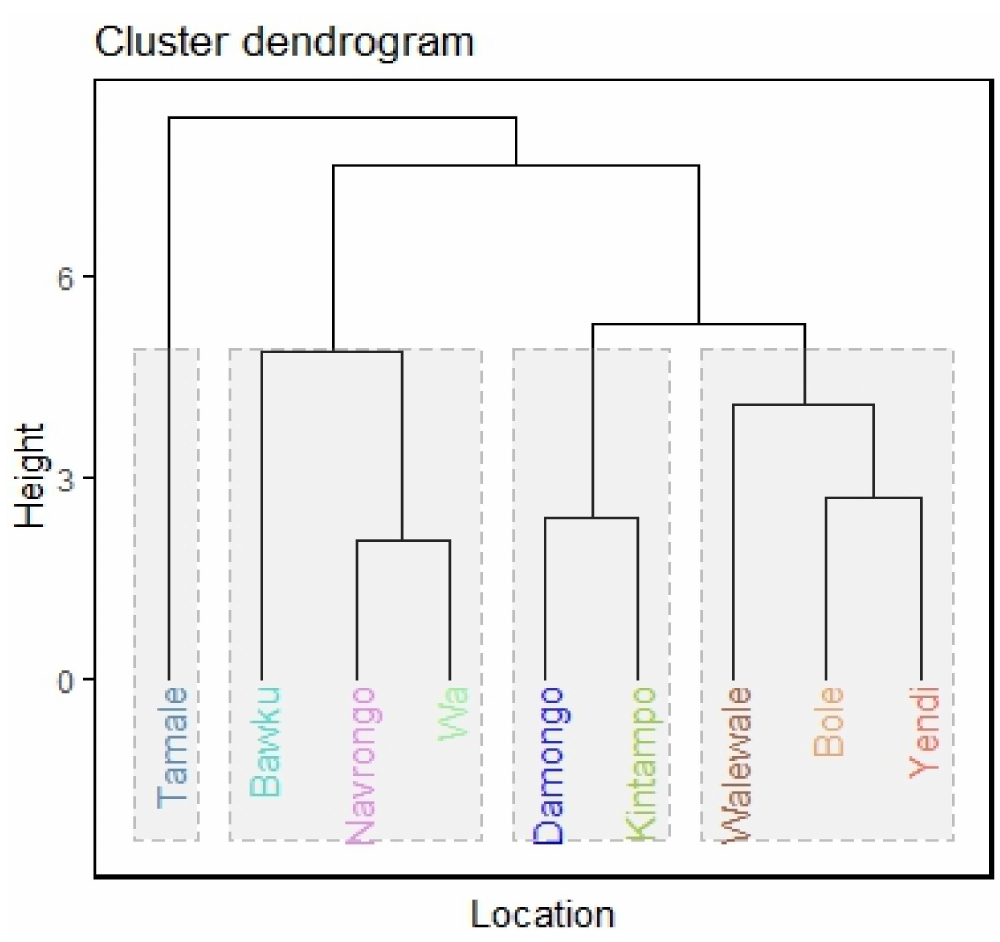
Figure 6. Clustering of assembled germplasms based on Pearson’s dissimilarity